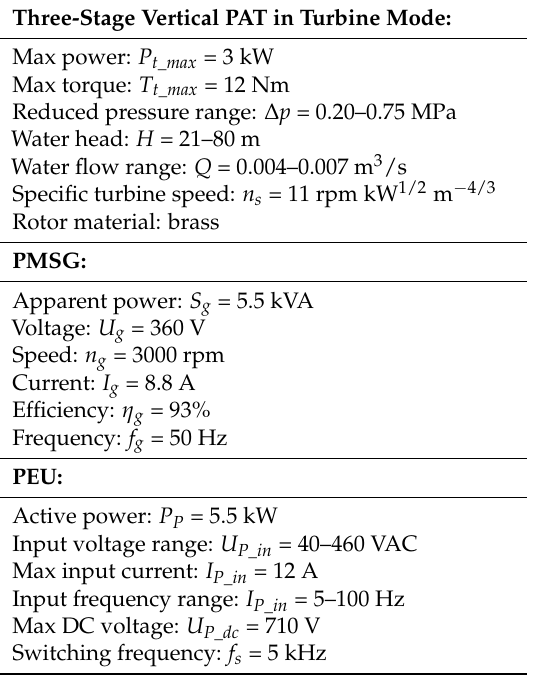
Table A1. Rated Values and Nominal